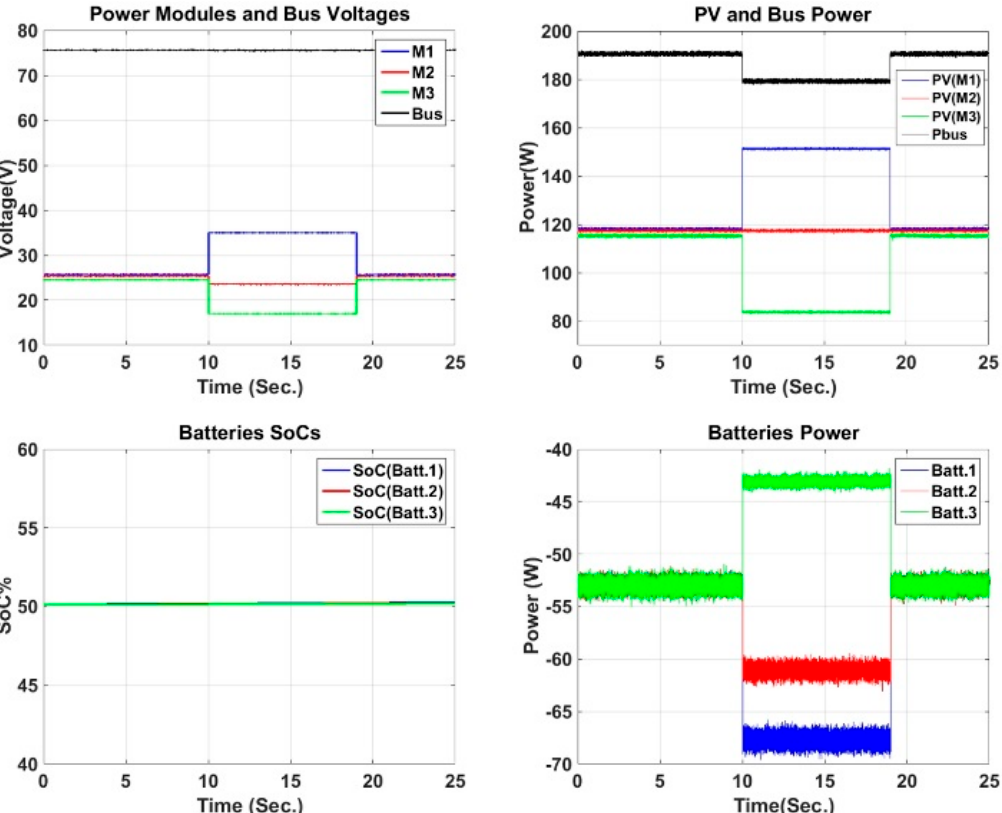
Figure 11. Managing battery charge balancing under unbalanced power from PVs.